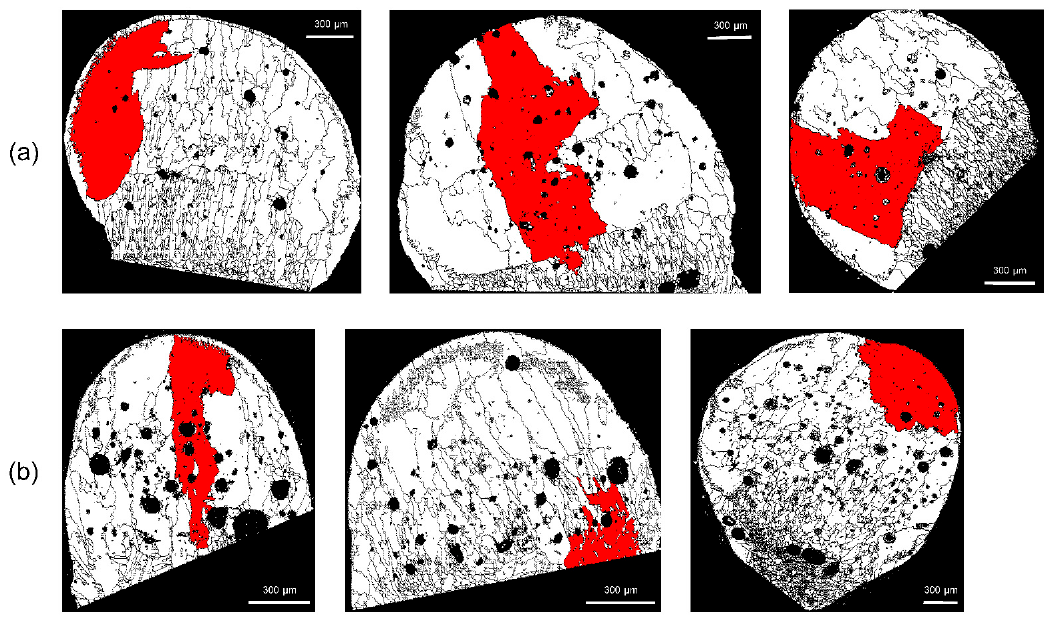
Figure 11. Color representation of the grain with maximum size: ( a ) SAB-600 and ( b ) SAB-900.